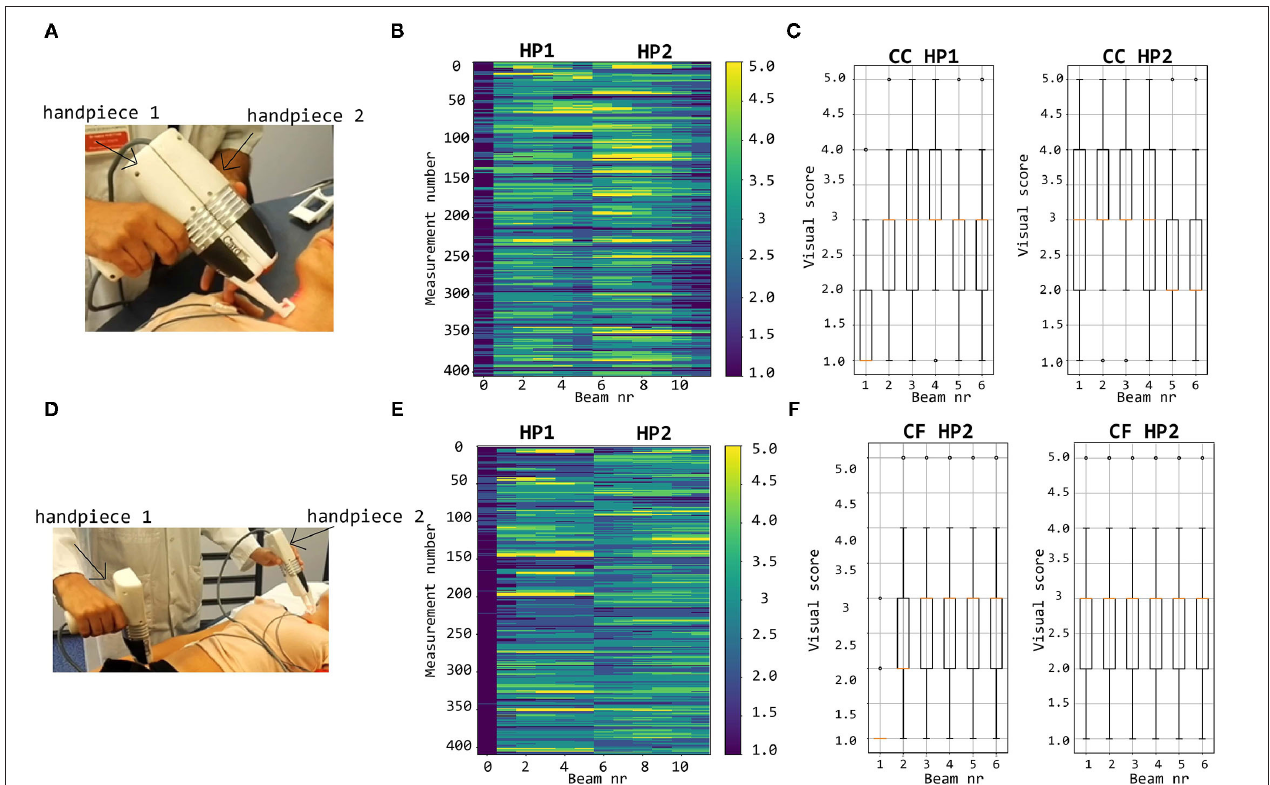
FIGURE 9 | Top row: visual scoring of signals measured with handpieces 1 and 2 during local carotid measurements (A) with overall grades shown in (B) and box plots and mean values per channel in (C) . Bottom row: visual scoring of signals measured during carotid-femoral PWV measurements (D) with overall grades shown in (E) and box plots and mean values per channel in (F) .